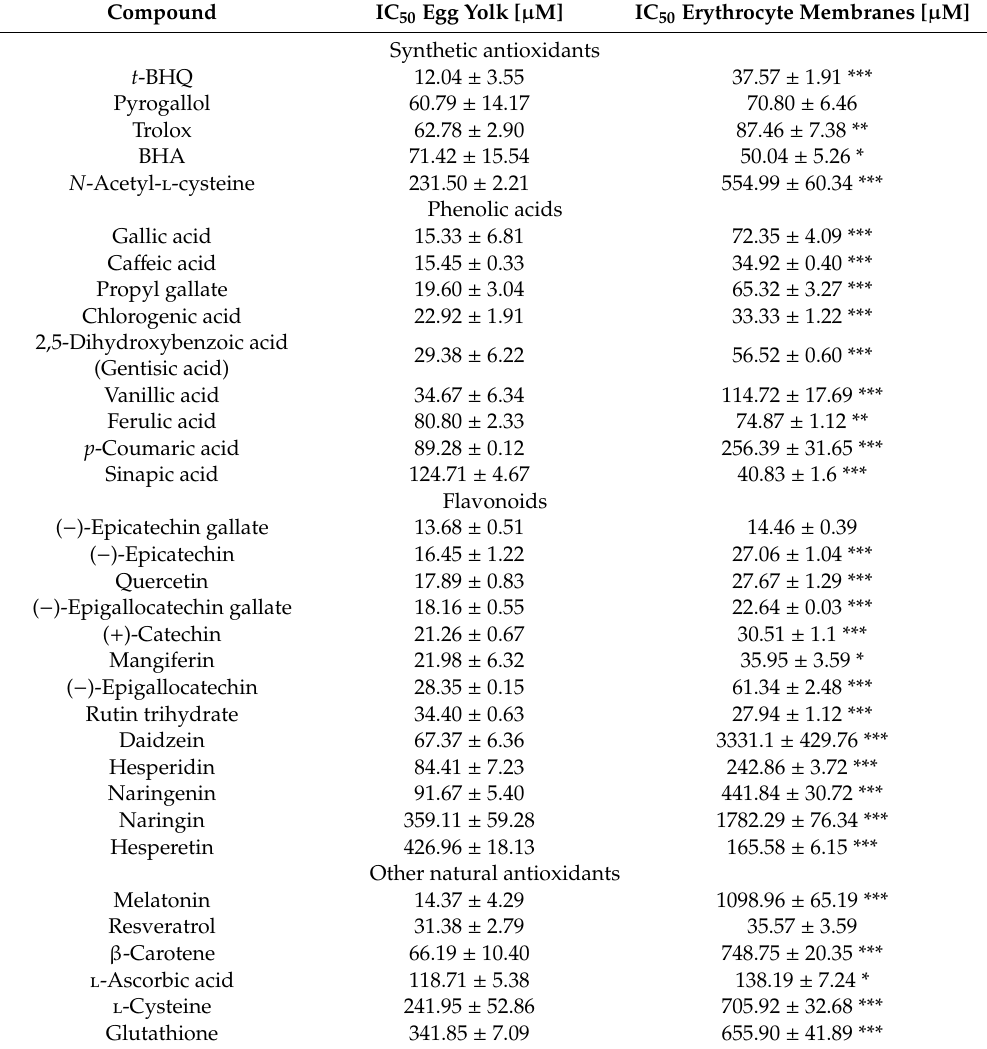
Table 1. Inhibition of BODIPY ® 581 / 591 oxidation by synthetic and natural antioxidants.